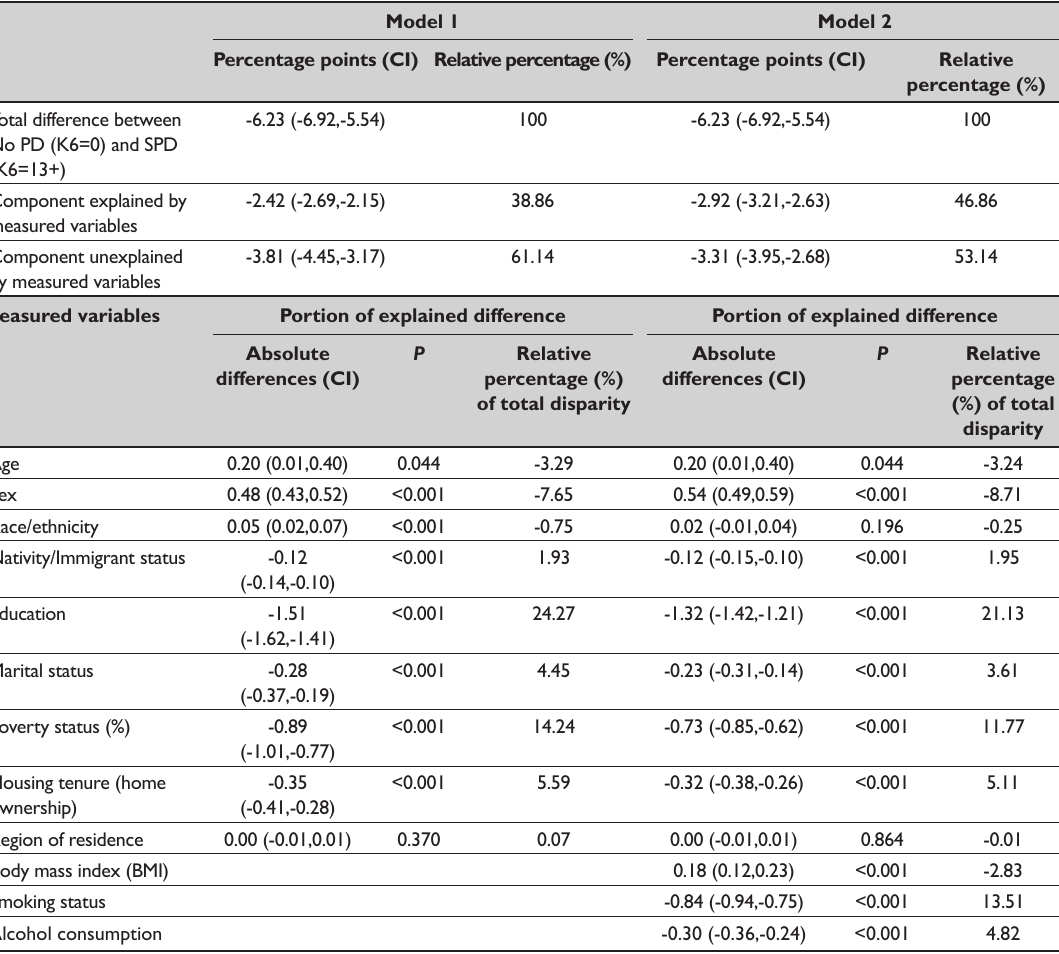
Table 2: Blinder-Oaxaca linear decomposition results for disparities in all-cause mortality between adults without psychological distress (PD) and with serious psychological distress (SPD), United